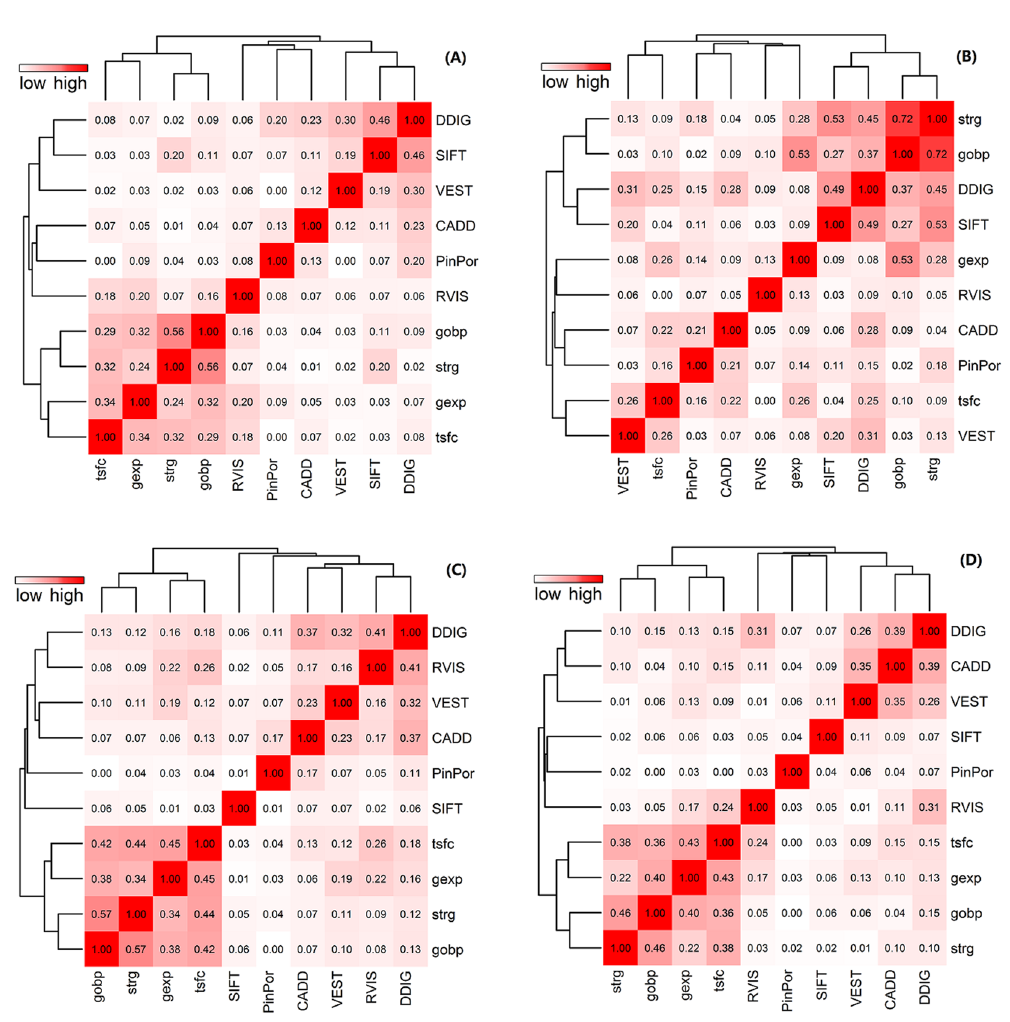
Figure 4. Correlations between individual genomic data. Pearson’s correlation coefficients between each pair of individual genomic data for: ( A ) nonframeshift deletion; ( B ) nonframeshift insertion; ( C ) frameshift deletion; ( D ) frameshift